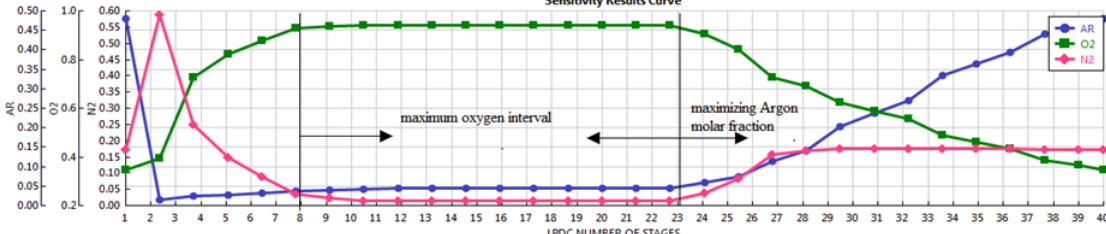
Figure 10. ARO2RECT molar fractions vs LPDC number of stages.